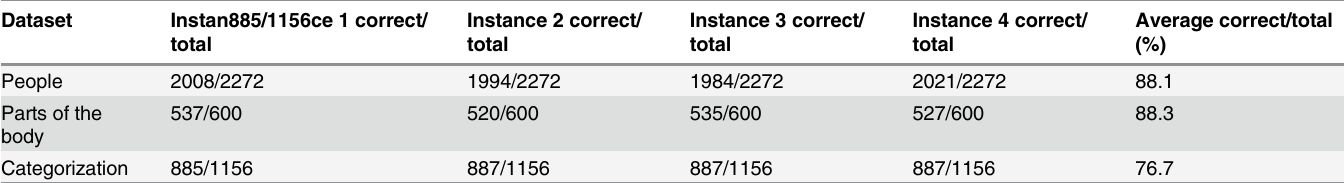
Table 7. Number of correct answers produced by the four instances of the system over the number of interrogative sentences for the three extended datasets people, parts of the body and categorization. The four instances of the system are the ones obtained by training the system on the original datasets during the four rounds of the cross-validation, respectively.